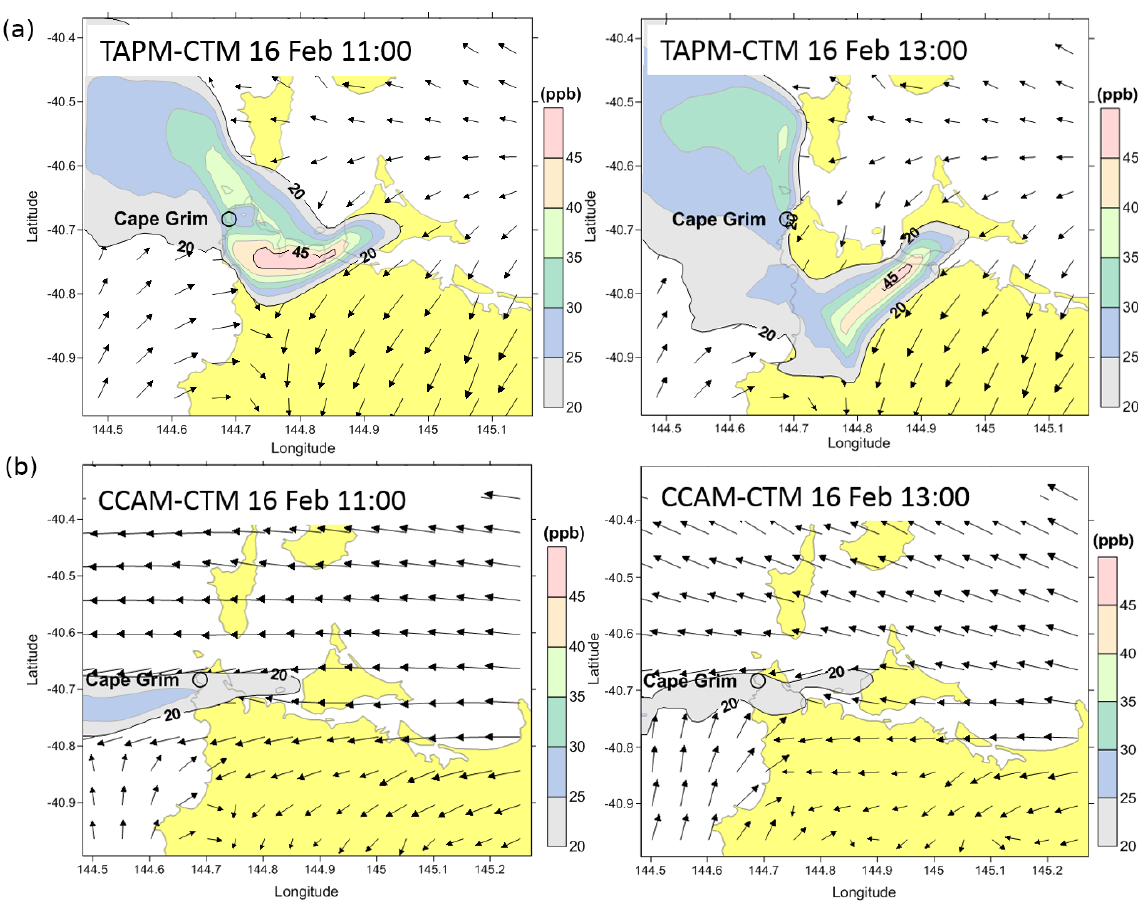
Figure 7. Model concentration isopleth showing O 3 enhancement downwind of the fire during BB1 at 11:00 and 13:00 on 16 February for (a) TAPM–CTM and (b) CCAM–CTM. The spatially variable plume and complex wind fields are shown. Arrows are wind